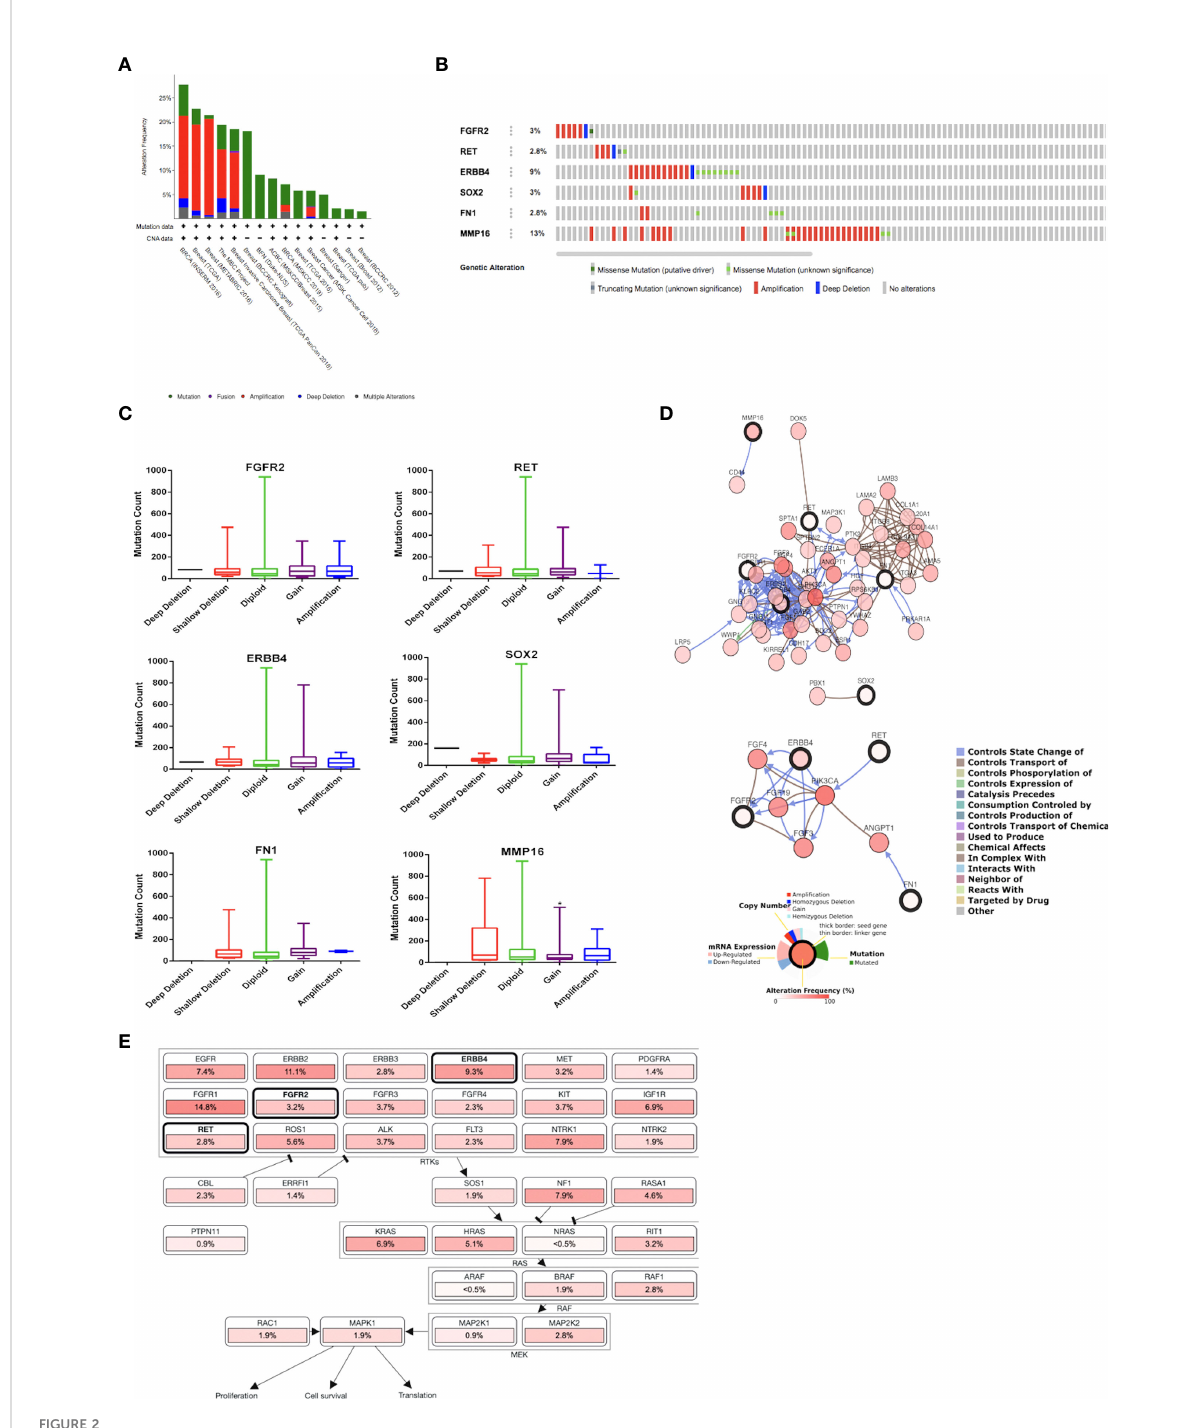
FIGURE 2 (A) Overview of changes in FGFR2 , RET , ERBB4 , SOX2 , FN1 , and MMP16 in genomics dataset from 15 studies on breast cancer. (B) Summary of alterations of FGFR2 , RET , ERBB4 , SOX2 , FN1 , and MMP16 across breast cancer samples [based on a study by Lefebvre et al. (2016)]. (C) Copy number of alterations of FGFR2 , RET , ERBB4 , SOX2 , FN1 , and MMP16 across breast cancer samples [based on a study by Lefebvre et al. (2016)]. Statistical analysis was conducted using the one-way ANOVA with Tukey ’ s multiple comparison test. * indicates p < 0.05. (D) Gene network connected with FGFR2 , RET , ERBB4 , SOX2 , FN1 , and MMP16 in breast cancer samples [based on a study by Lefebvre et al. (2016)]. (E) Pathway enrichment analysis related to the genetic alterations in FGFR2 , RET , ERBB4 , SOX2 , FN1 , and MMP16 across breast cancer samples [based on a study by Lefebvre et al.